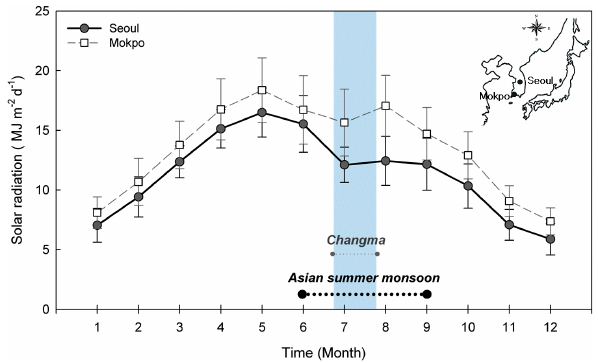
Fig. 1. Variations of 30-year (1971–2000) averaged daily solar ra- diation per month at Seoul and Mokpo in Korea. Seoul is located near the deciduous forest (the GDK site), while Mokpo is located near the farmland site (the HFK